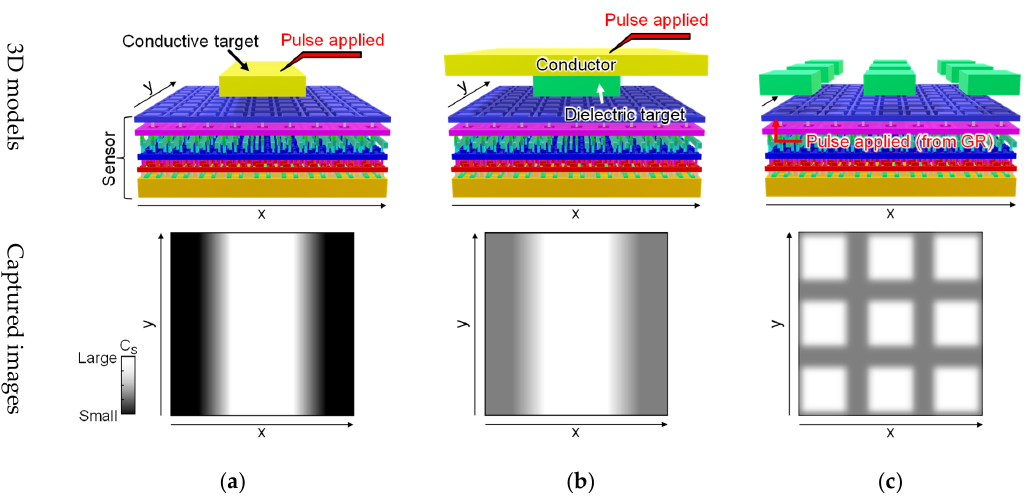
Figure 1. The 3D models of the sensor and the target, and the captured images for each target: ( a ) conductive target; ( b ) dielectric target; ( c ) particulate targets.